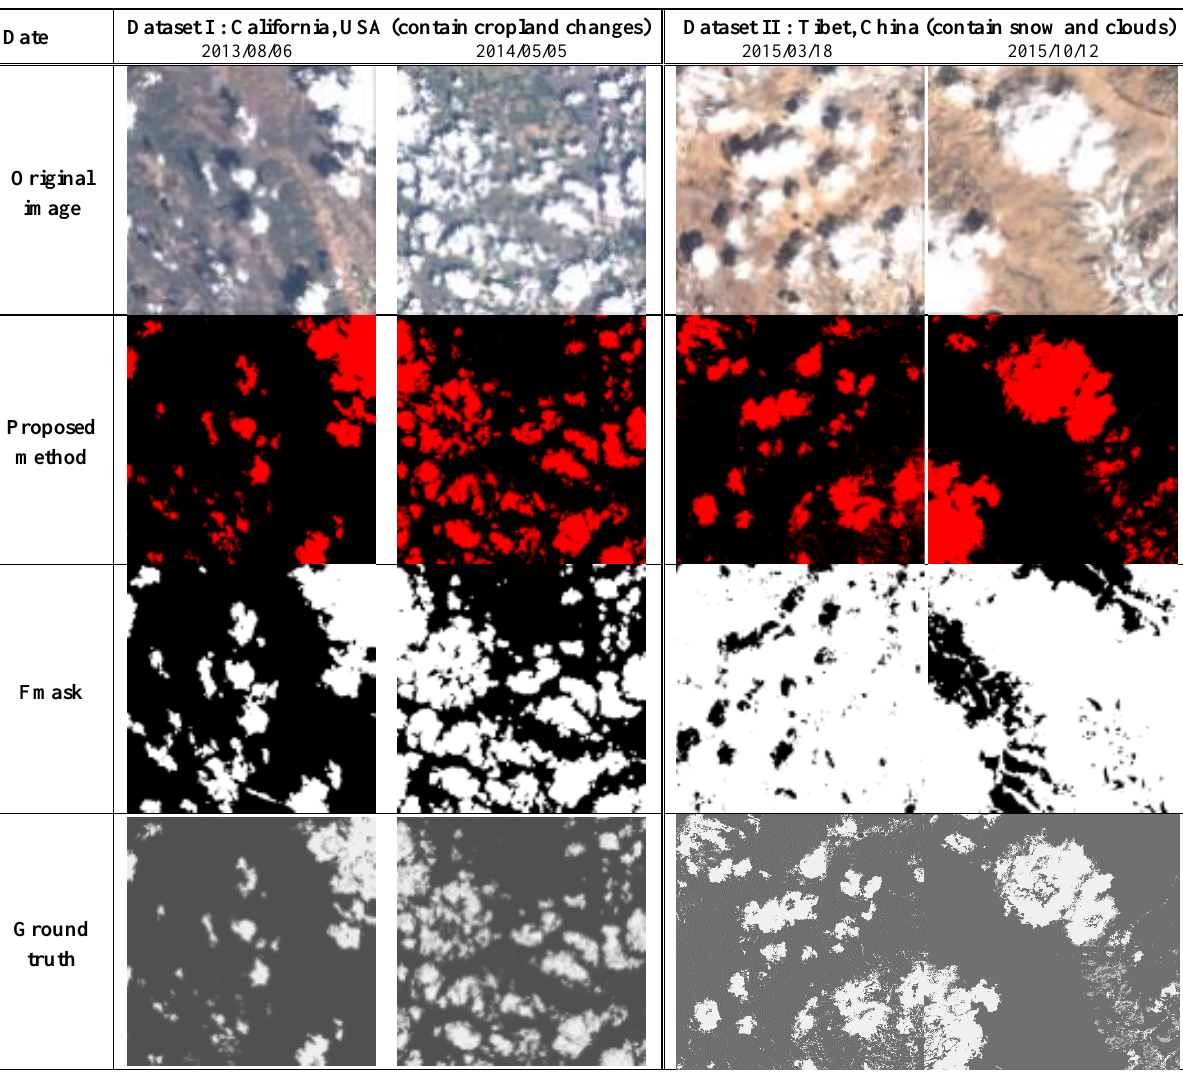
Table 2. Comparison of texture features in dataset I. Precision